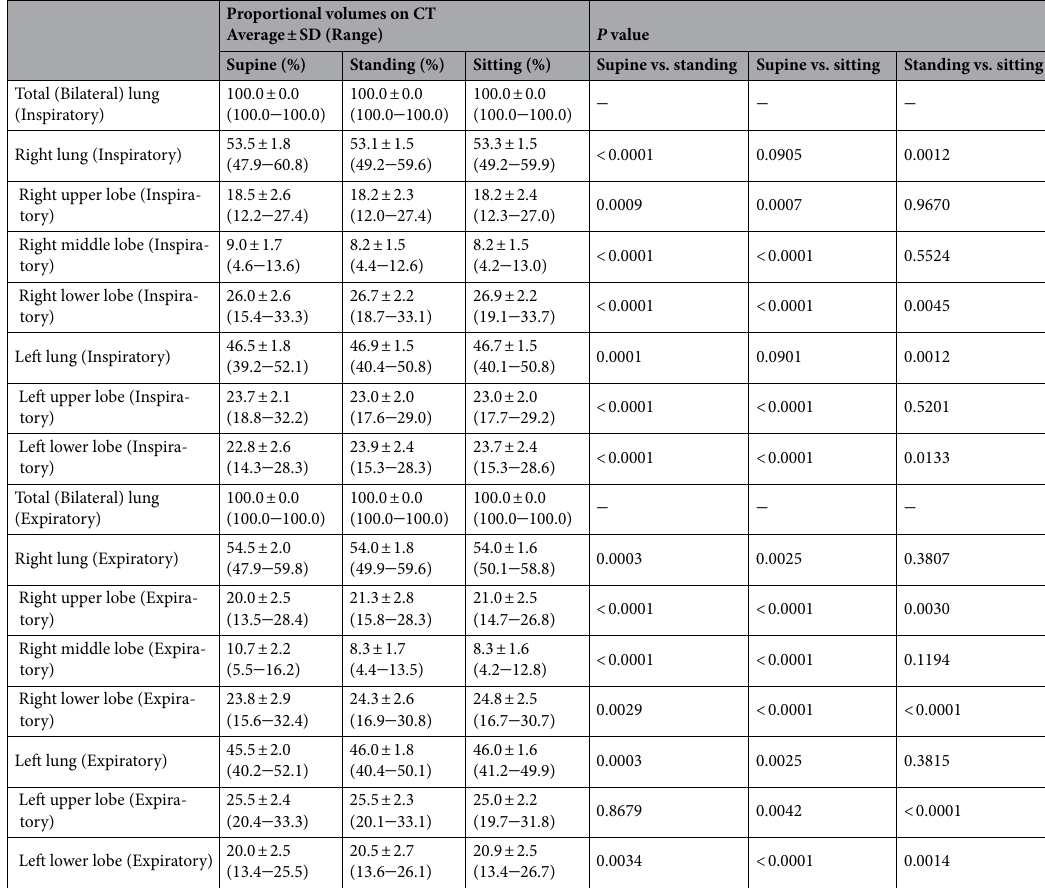
Table 3. Proportional volumes of each lung and each lobe relative to the total lung volume as determined using CT in supine, standing, and sitting positions (100 volunteers). P < 0.0167 was considered to be statistically significant, with Bonferroni correction for multiple comparisons.